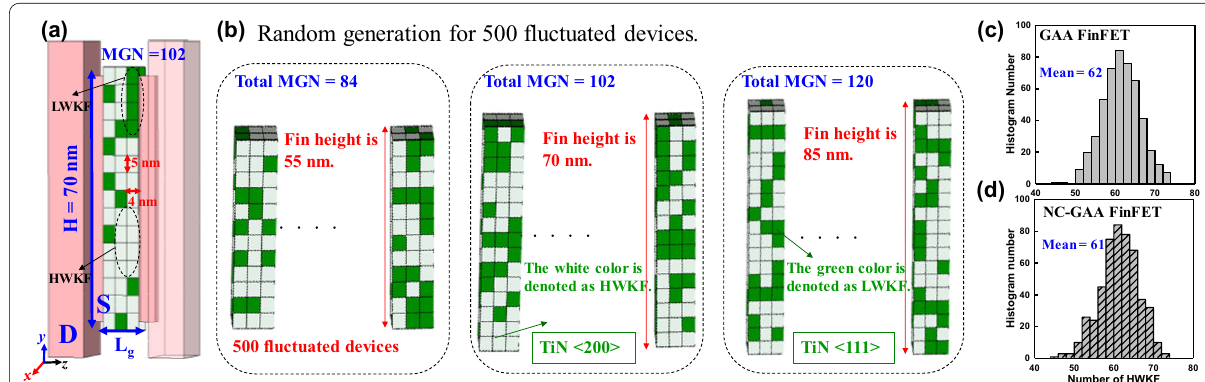
Fig. 3 a The schematic plot of the device with the fin height of 70 nm which has the WK random distribution. b The illustrations of random generation devices with the different MGNs. Notably, the white grain color is represented as HWKF; the green grain color is denoted as LWKF. The Gaussian distributions with HWKF for c GAA and d NC‑GAA FinFETs under the fixed MGNs